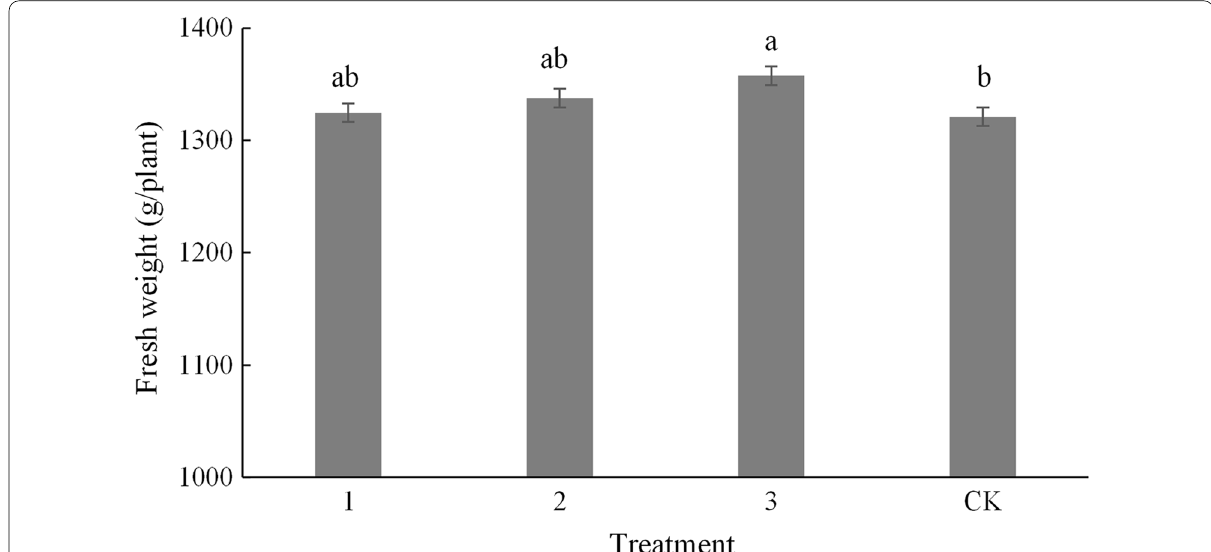
Fig. 2 The tomato plant fresh weight of different treatments in the field. 1 was JTB8–2 agent 0.8 L/105m 2 ; 2 was JTB8–2 agent 1.6 L/105m 2 ; 3 was JTB8–2 agent 3.2 L/105m 2 ; CK was blank control